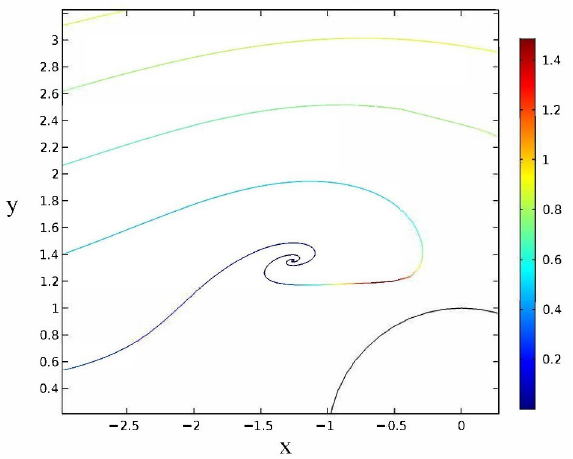
Figure 4. Zoom of particle trajectories for an applied electric field perpendicular to flow direction in the case of low frequency and Λ = 1. The colors represent the magnitude of the particle velocity in units of v 0